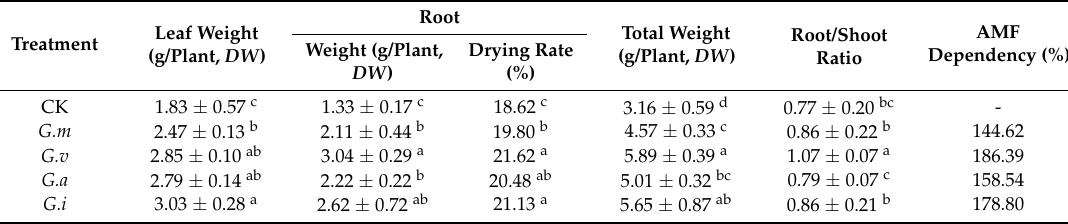
Table 4. Effect of AMFs inoculation on biomass of S. miltiorrhiza